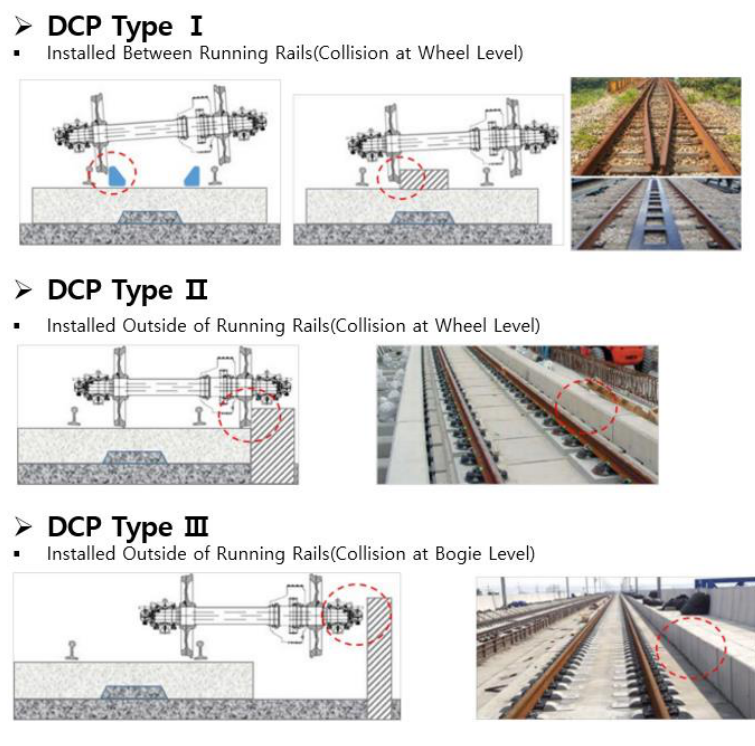
Figure 1. Types of DCPs and their characteristics.